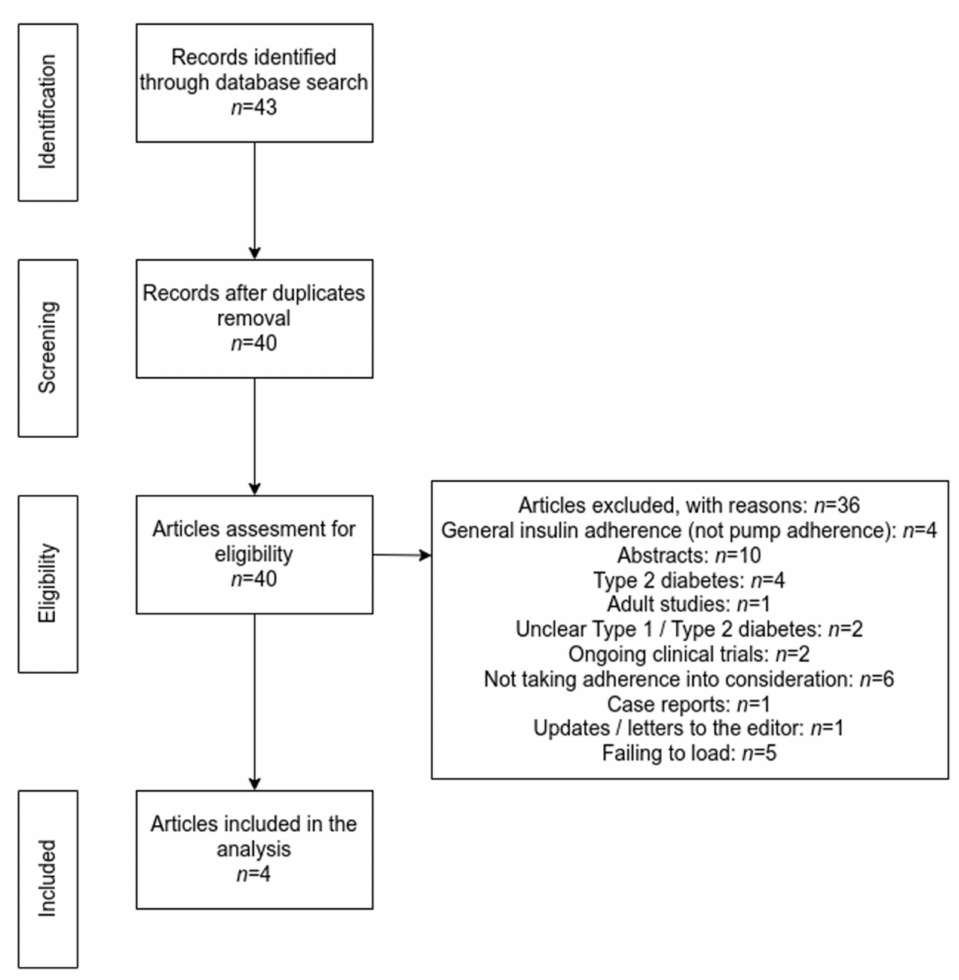
Figure 1. Review methodology Prisma